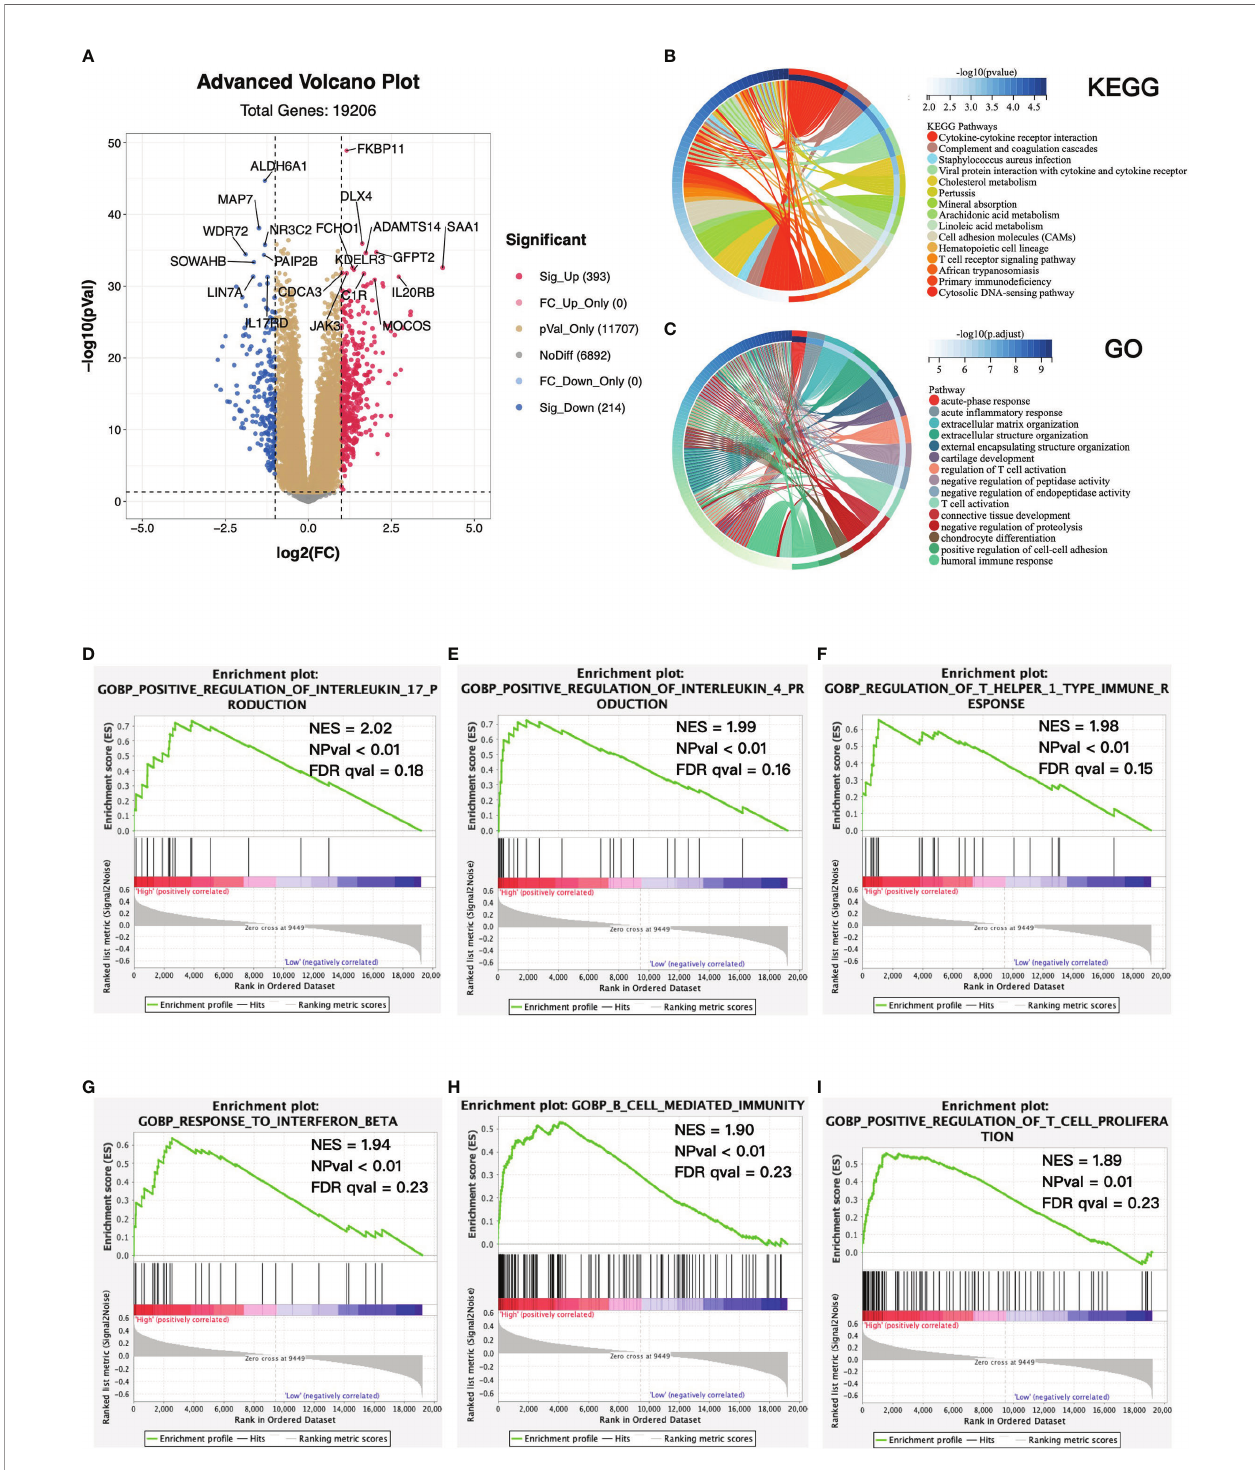
FIGURE 6 | Functional enrichment between high- and low-risk groups. (A) Volcano plot of differentially expressed genes (DEGs) between high- and low-risk groups. Log2(fold change) > 1, adjusted p-value < 0.05. KEGG (B) and GO (C) enrichment analysis base on upregulated DEGs. Top 15 enriched pathways were presented. (D – I) GSEA between high- and low-risk groups. KEGG, Kyoto Encyclopedia of Genes and Genomes; GO, Gene Ontology; GSEA, gene set enrichment analysis; NES, normalized enrichment score; NPval, nominal p-value; FDR qval, FDR